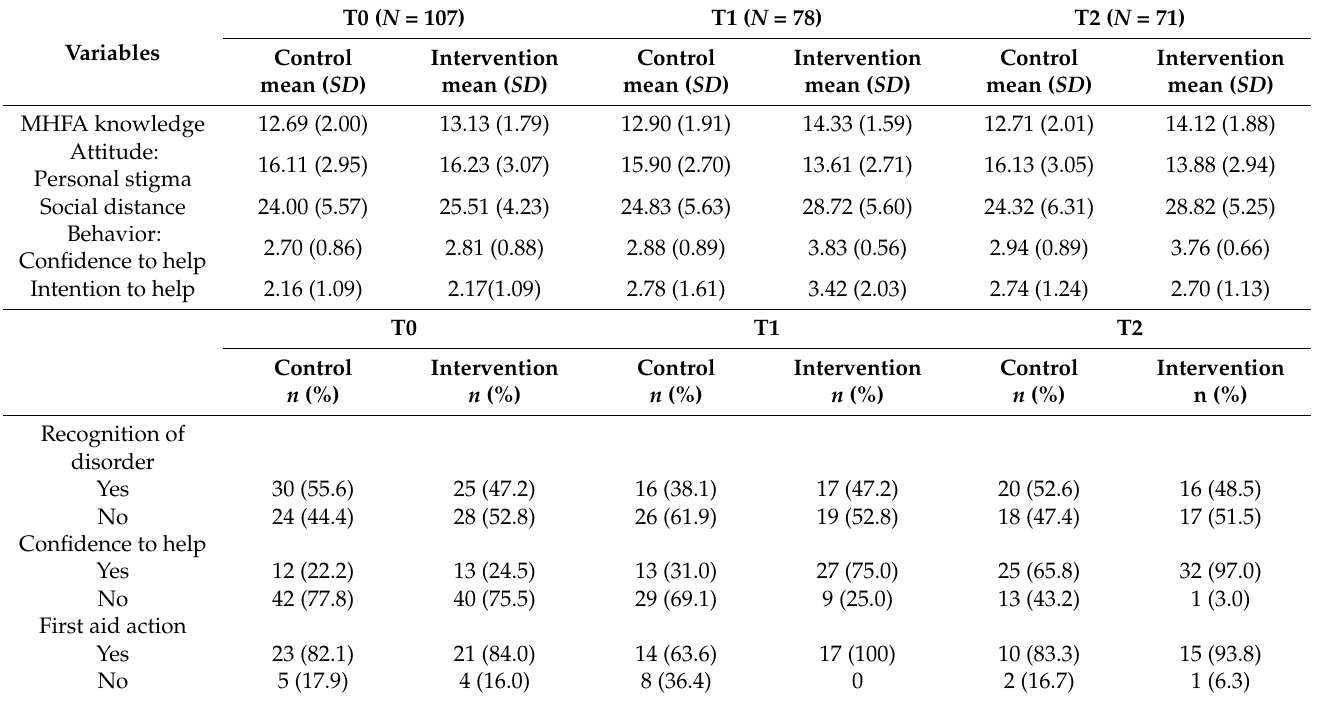
Table 2. Comparing knowledge, attitude, and behavior in Control and Intervention groups at three-time